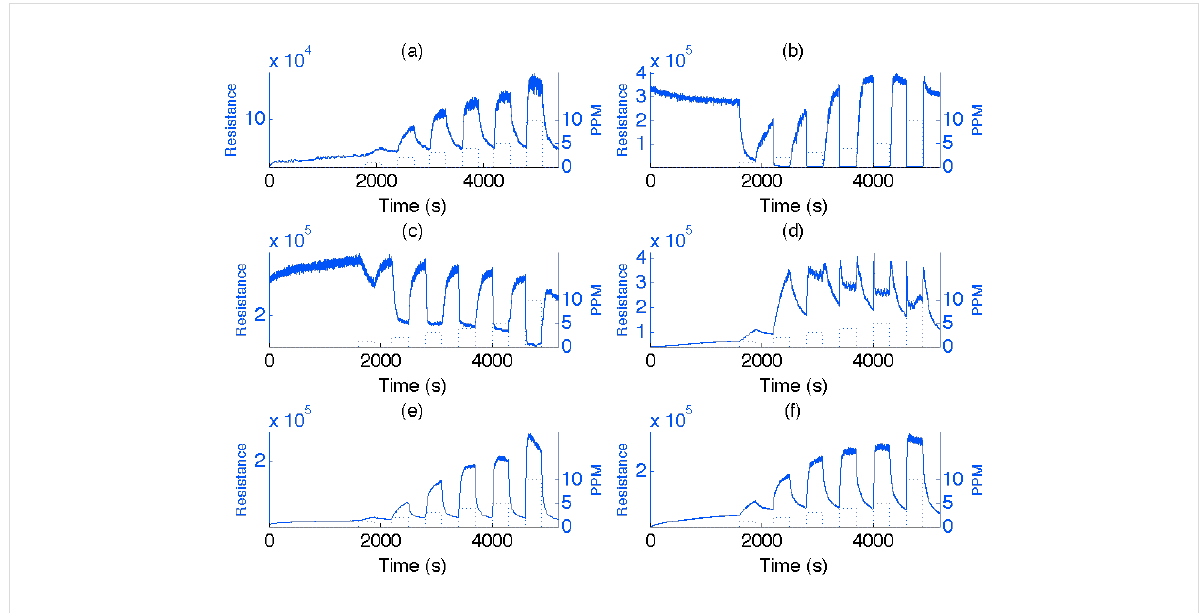
Figure 8: Comparison of responses to 1–5 and 10 ppm NO for (a) an untreated n-type PS micro/nanostructured interface with those treated with (b) TiO 2, (c) SnO 2 , (d) NiO, (e) Cu x O, and Au x O fractional nanostructured island depositions. NO was pulsed onto these interfaces with a 300 s half-cycle followed by a 300 s half-cycle nitrogen cleaning. The system was purged with UHP nitrogen for 1800 s before